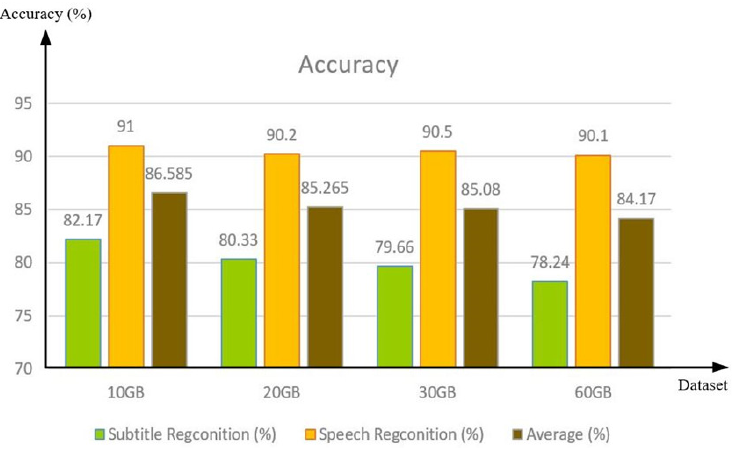
Figure 17. Average accuracy for three Scenarios 1–3.